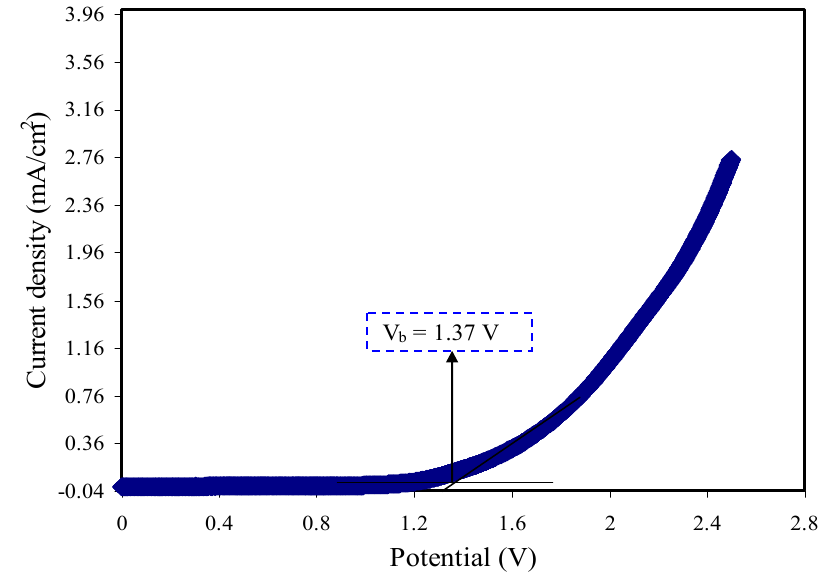
Figure 10. Linear sweep voltammogram (LSV) plot for the highest conducting CSNZG3 electrolyte sample.